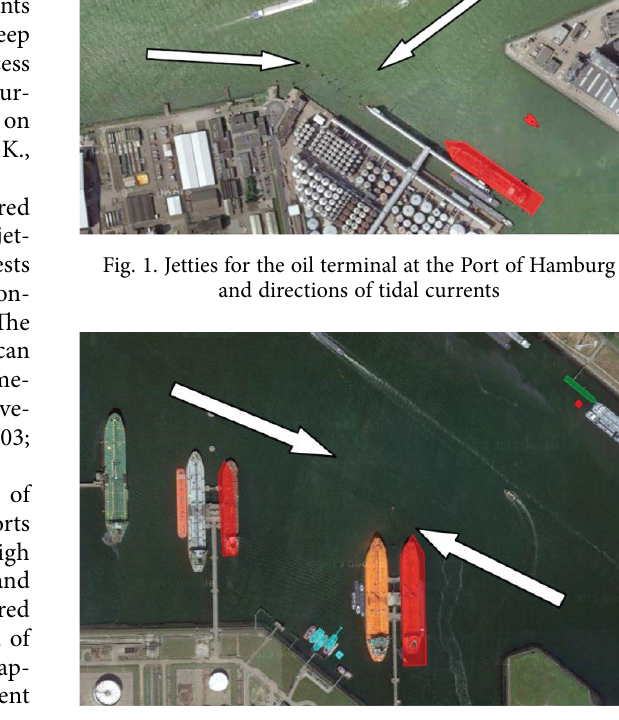
Fig. 2. Jetties for the oil terminal at the Port of Rotterdam and directions of tidal